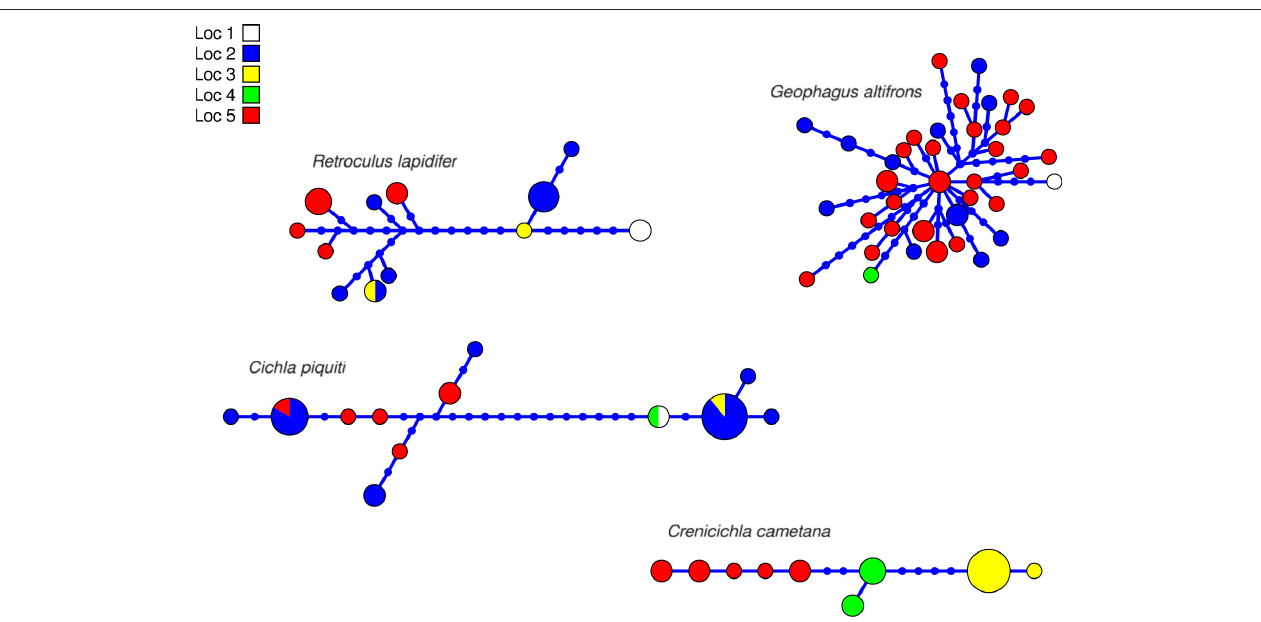
FIGURE 3 | Haplotype network of four species of Cichlidae indicating geographic occurance of the haplotypes. Networks were generated in HAPVIEW , and haplotype size is proportional among networks and to the number of individuals with that haplotype. Localities are: (1) Zé dos Gatos rapid; (2) São Miguel rapid; (3) Remanso dos Botos rapid; (4) Santa Isabel rapid; (5) São Bento rapid and Rebojo rapid.